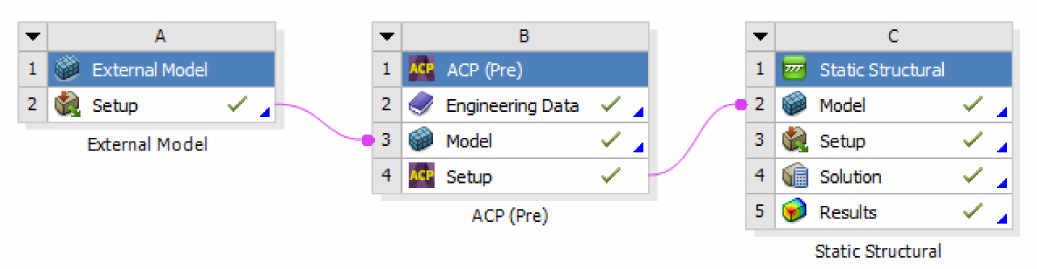
Figure 16. Workflow for numerical analysis of tensile test.